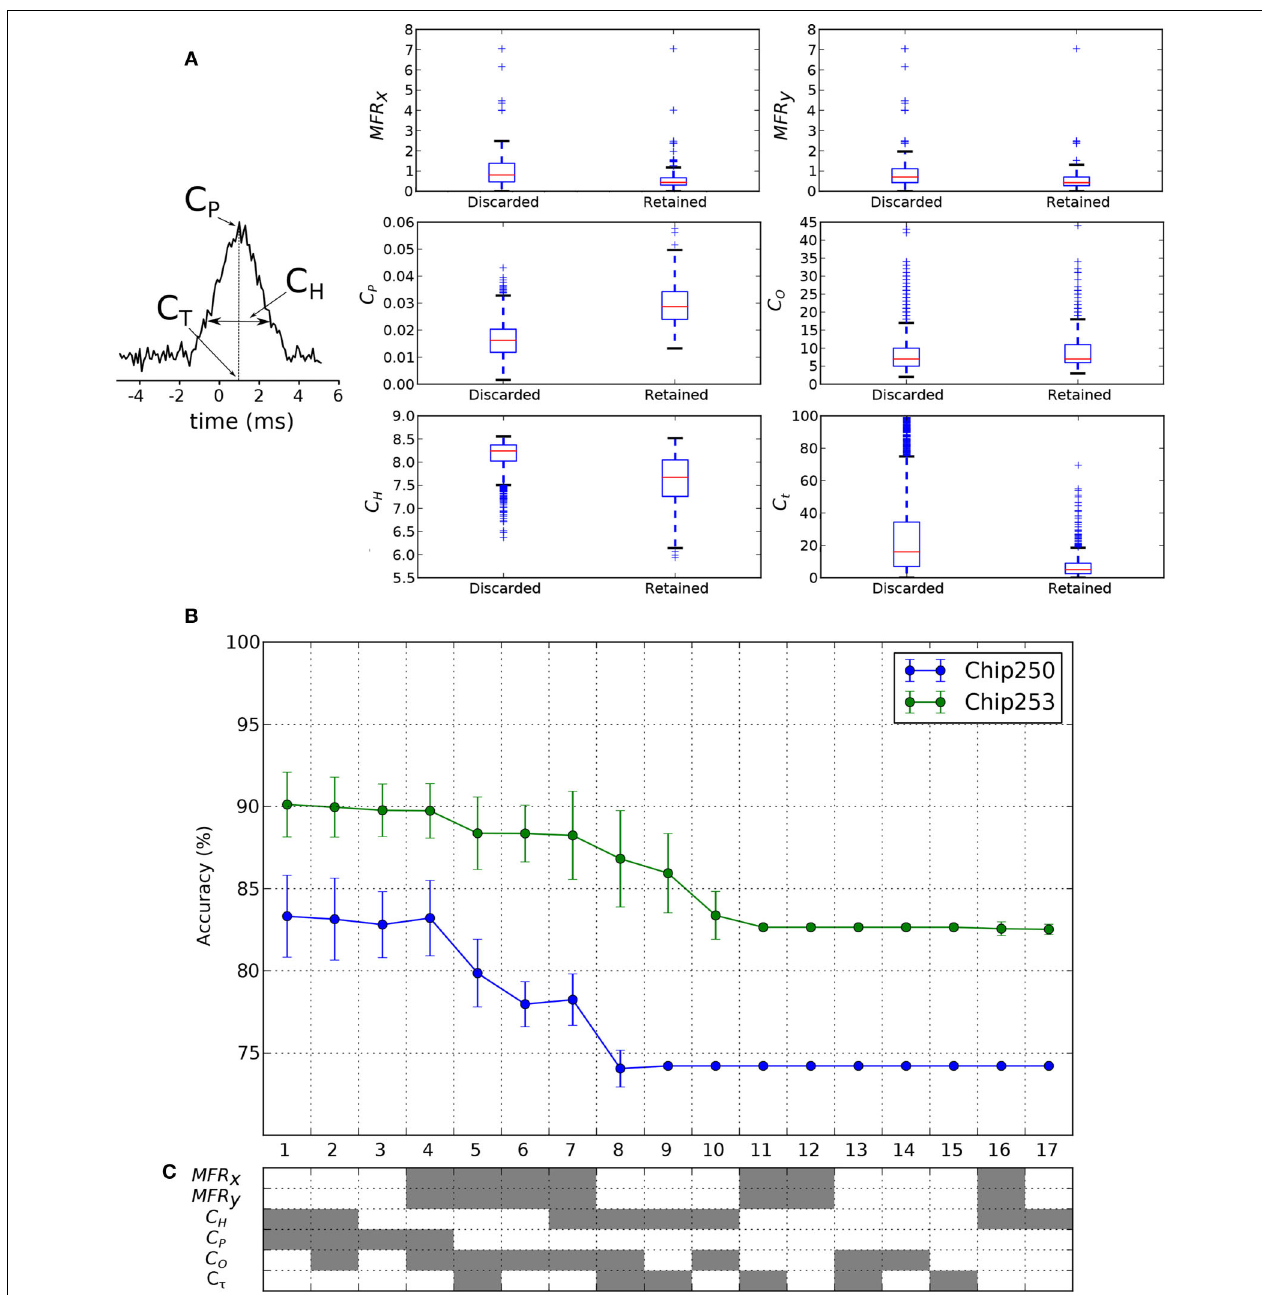
FIGURE 8 | Classification features and results. (A) Cross-correlation features used in the classification process. The peak of cross-correlation C P , its peak time C τ and the corresponding spread C H are considered. (B) Box plots of the feature distributions in the discarded and retained link classes.